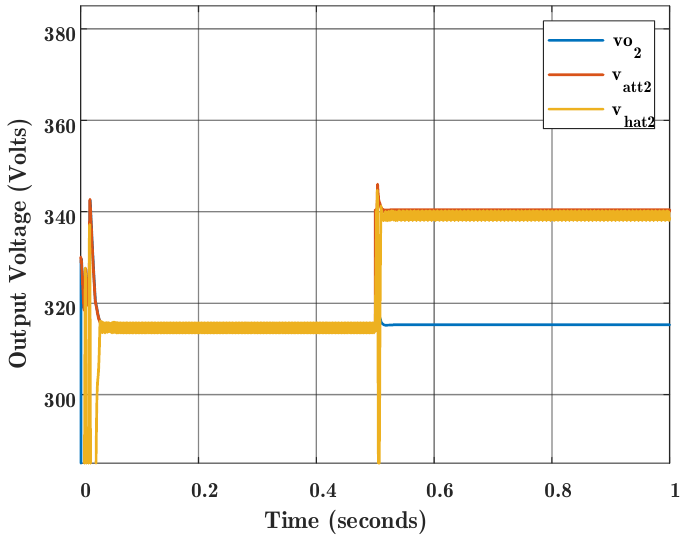
Figure 5. Voltage values for Agent 2, and the concept for what happens when an attack occurs; Vo 2 is the real output voltage for Agent 2, V att 2 is the information about voltage of Agent 2 that is delivered over the communication link to Agent 3, which is manipulated by the false data injection attack, V hat 2 is the voltage observer for Agent 2 that is located in Agent 3.